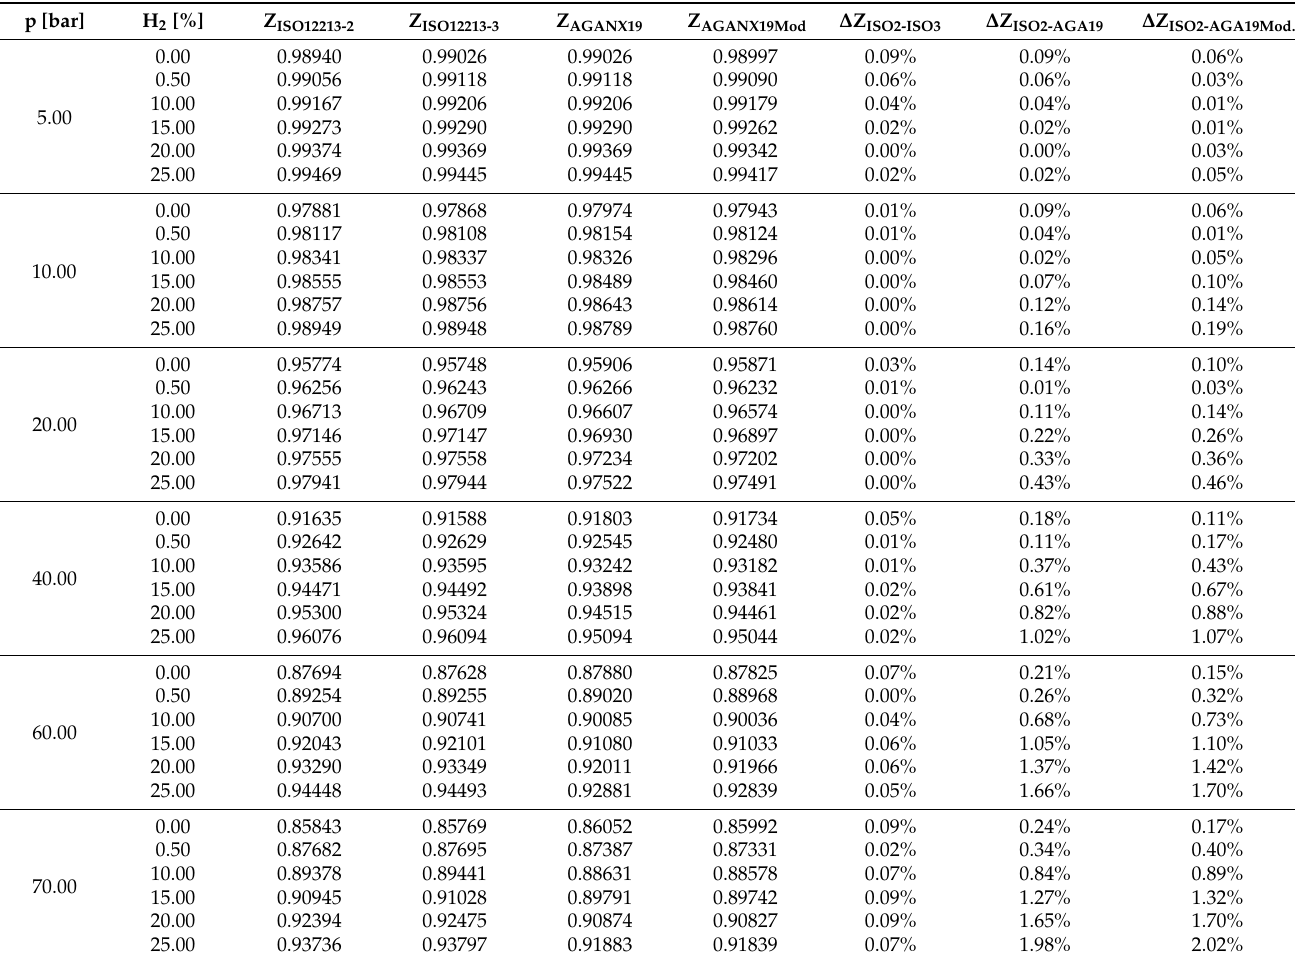
Table 5. Compressibility factor values evaluated employing the ISO 12213-2, ISO 12213-3, AGA NX 19 and AGA NX 19